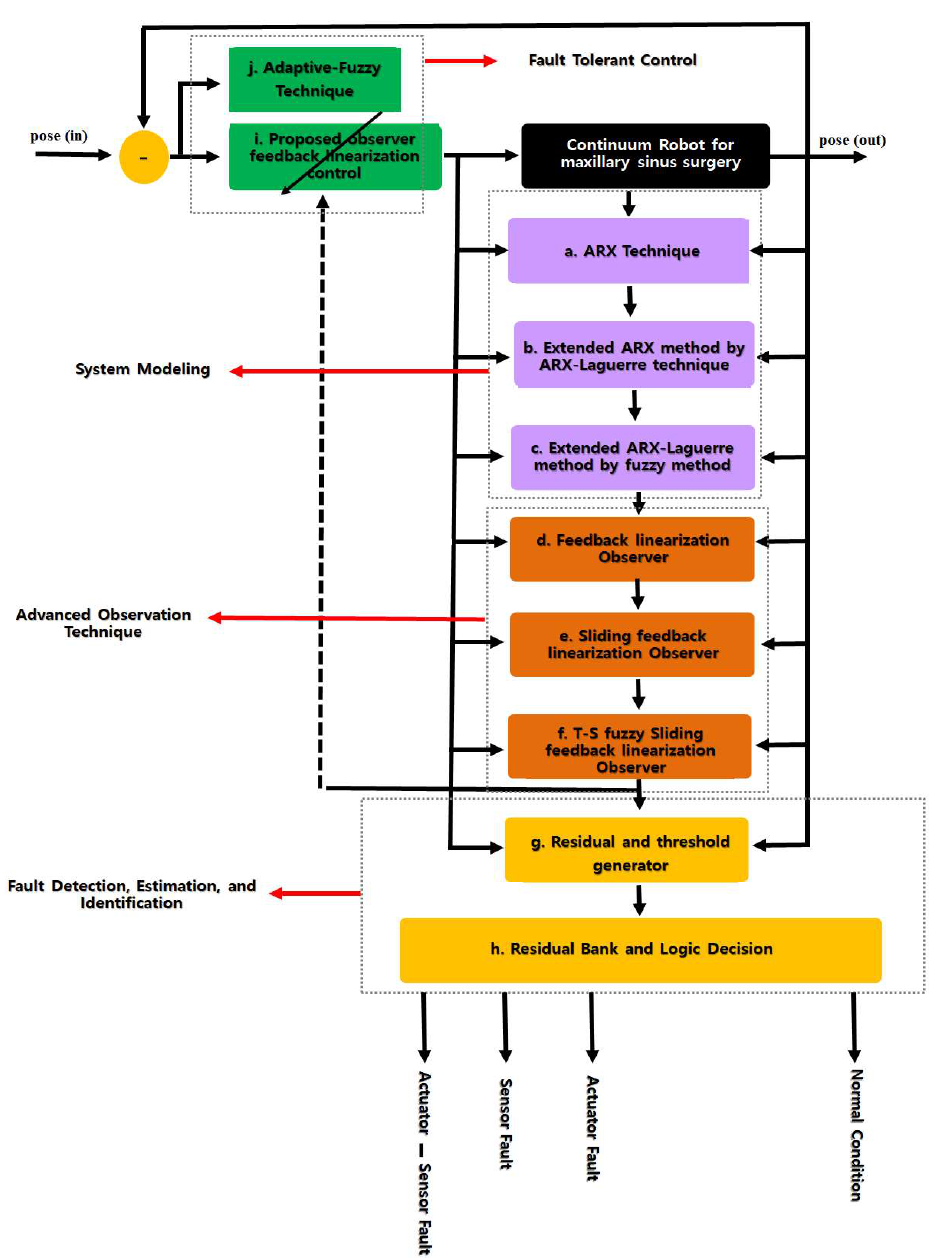
Figure 2. The proposed algorithm for fault detection, estimation, identification, and tolerant control of a maxillary sinus continuum robot surgery.